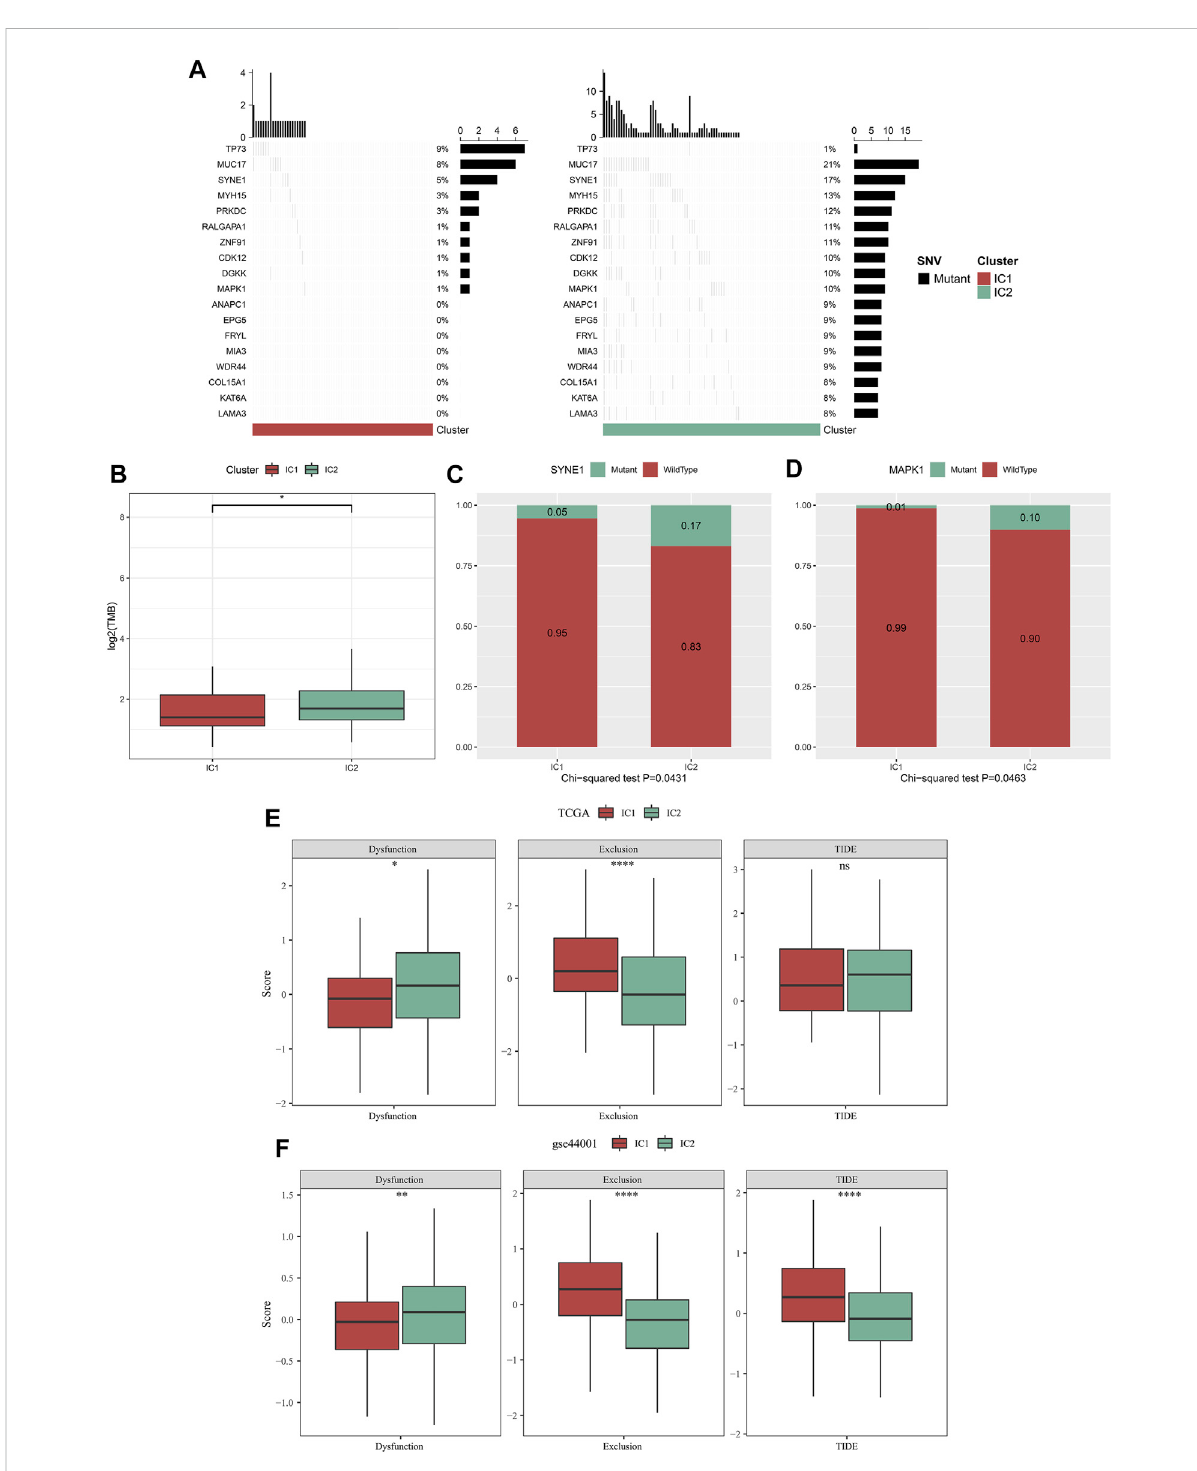
FIGURE 6 Immune subtypes with distinct genetic mutations and immunotherapeutic responses. (A) Waterfall diagrams of the mutational frequencies of genes with remarkable differences between IC1 and IC2 immune subtypes in the TCGA dataset. (B) Comparison of TMB between two immune subtypesintheTCGAdataset. (C,D) ComparisonofmutationfrequenciesofSYNE1andMAPK1betweenimmunesubtypesintheTCGAdataset. (E,F) Comparisonofdysfunction,exclusion,andTIDEscorebetweenimmunesubtypesintheTCGAandGSE44001datasets(ns,nosigni fi cance;* p